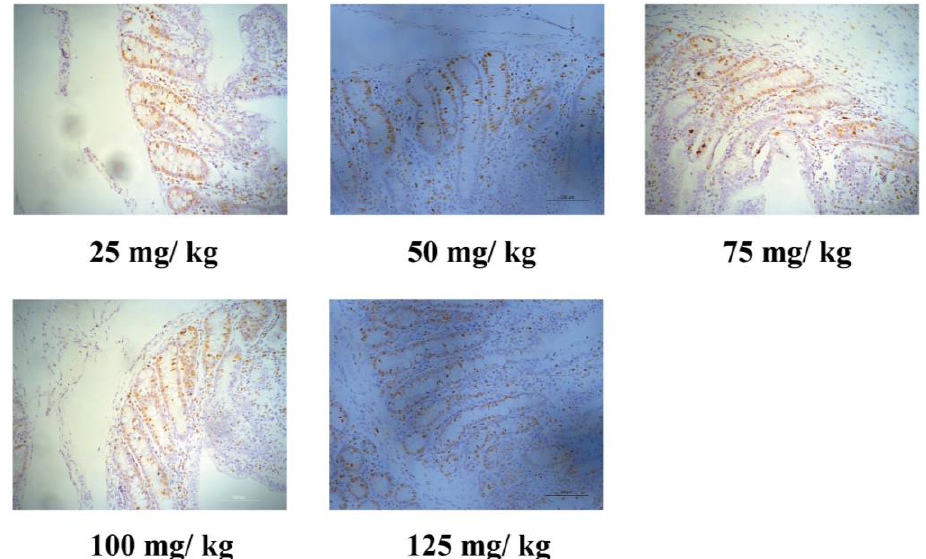
Figure 1. Representative immunohistochemical images of the Ki67-positive cells in the jejunum of weaned piglets. Pigs were supplemented with 25, 50, 75, 100, and 125 mg CuSO 4 /kg dry matter at the weaning phage (phase 1). Note Scale bars, 100 μm (magnification 200×).